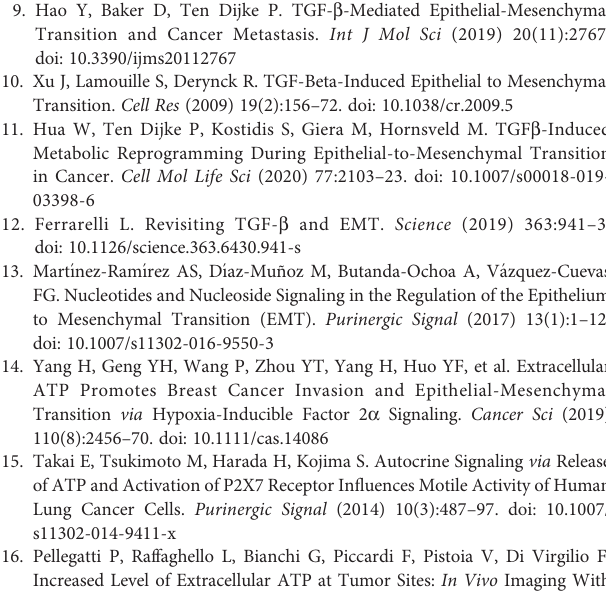
Supplementary Figure6 | Quanti fi cation ofthe soft-agarcolony formation assay. This quanti fi cation is for the assay shown in Figure 8G. Supplementary Table 1 | Epithelial genes signi fi cantly changed by either ATP or TGF- b treatment. Supplementary Table 2 | FPKM values of three replicate samples for each gene for heatmap in Figure 1G. Supplementary Table 3 | FPKM values of three replicate samples for each gene for heatmap in Figure 1H. Supplementary Table 4 | FPKM values of three replicate samples for each gene for heatmap of Figure 4D. Supplementary Table 5 | FPKM values of three replicate samples for each gene for heatmap of Figure 5E. Supplementary Table 6 | FPKM values of three replicate samples for each gene for heatmap of Figure